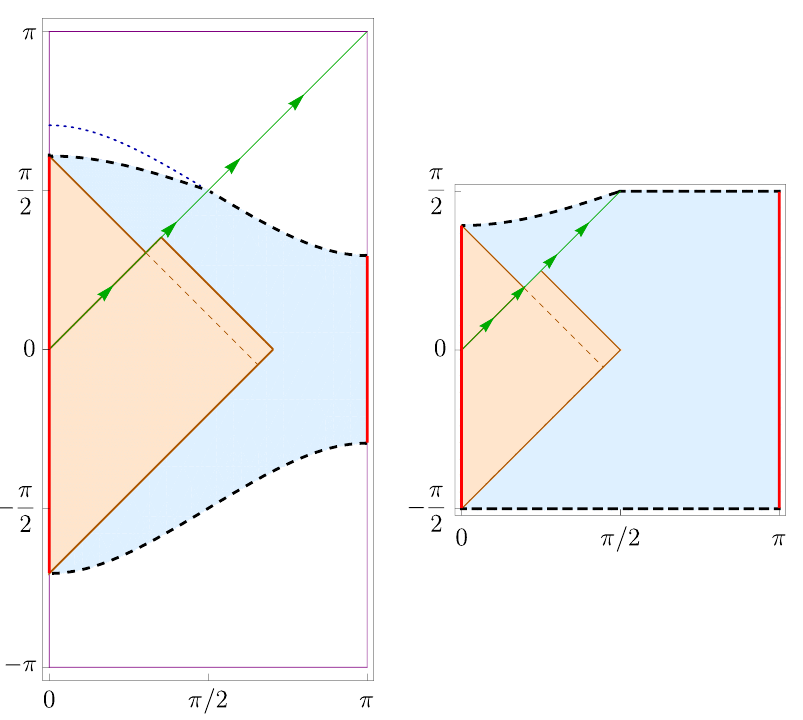
Figure 4: A solution describing a matter pulse T −− = δµδ ( x − ) on a µ > 0 solution of the b = 0 model. The diagram on the left shows the relevant regions on the conformal diagram of the unphysical AdS spacetime, using the same conventions as Figure 2. 2 The shaded X > 0 regions for vacuum solutions before ( µ ) and after ( µ + δµ ) the pulse are joined along the green line T − σ = 0. The X = 0 curve for the vacuum solution µ is continued into the T − σ > 0 region as a dotted line. The diagram on the right shows the corresponding region on the (right half of the) dS conformal 2 diagram for the µ > 0 spacetime. In both diagrams the diagonal dashed line indicates a horizon that separates part of the original static patch from an observer at r =